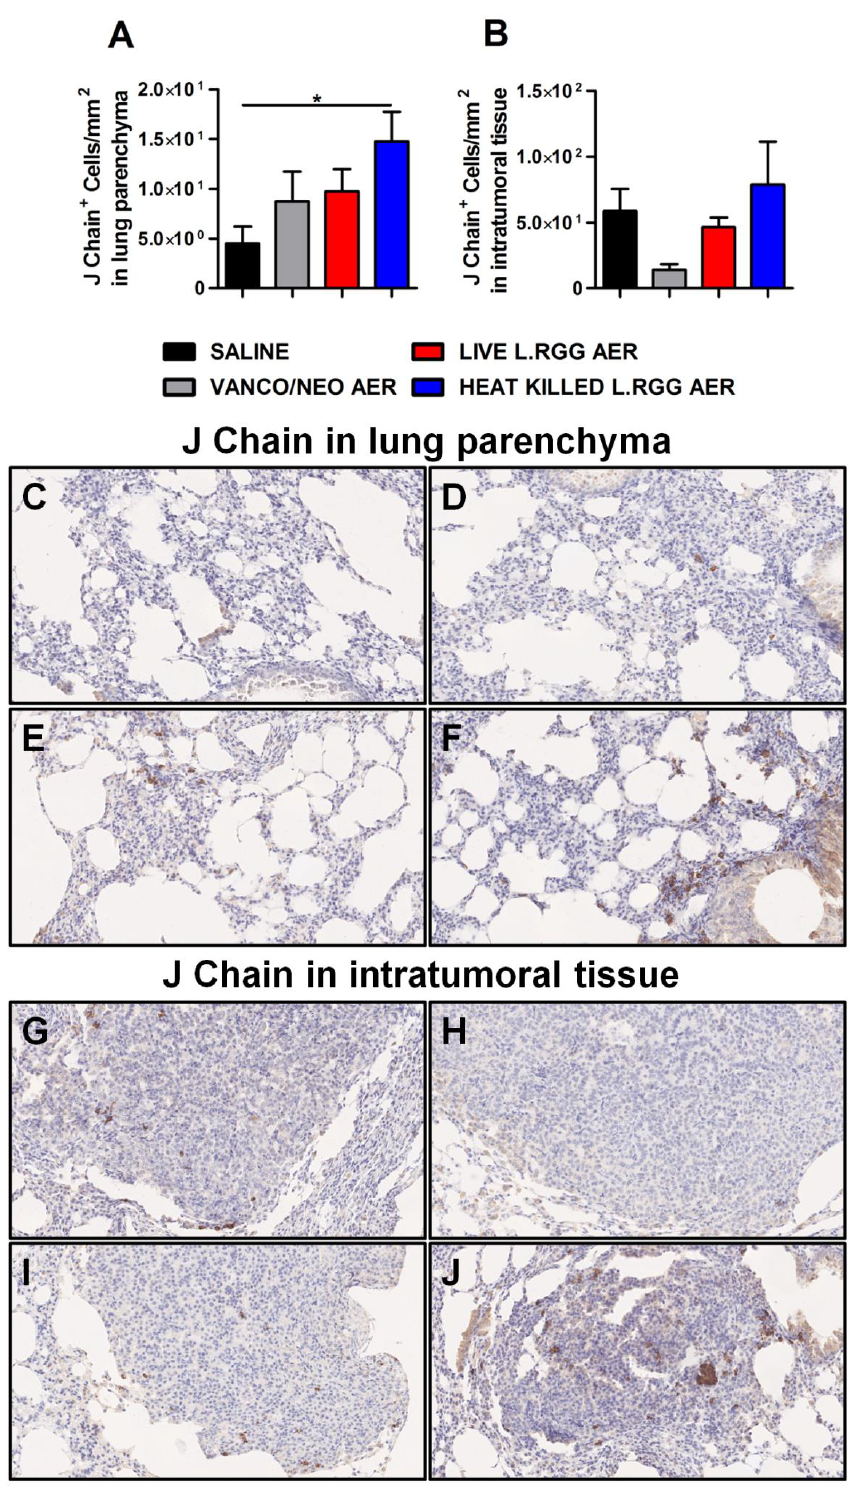
Figure 3. Impact of antibiotics and probiotic aerosolization on J chain protein expression in the lung. Lung parenchyma ( A ) and intratumoral tissue ( B ) J chain protein level in formalin-fixed, paraffin-embedded lung specimens evaluated by IHC. Data are expressed as positive cells/mm 2 (4 section/lung, 8 – 9 mice/group) (mean ± SEM). Lung parenchyma and intratumoral tissue representative staining with anti-mouse J chain antibody in saline- ( C , G ), vanco/neo- ( D , H ), live L.RGG- ( E , I ) and heat-killed L.RGG - ( F , J ) treated lungs are shown; 20 × magnification. * p ≤ 0.05 by unpaired Student t